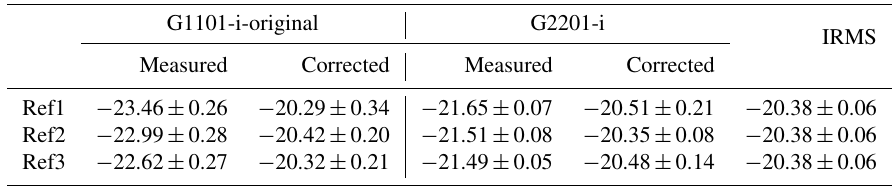
Table 2. The stability and accuracy of δ 13 C values of the three reference gases (Ref1, Ref2, and Ref3) with same δ 13 C measured by G1101-i before upgradation (G1101-i-original) and G2201-i